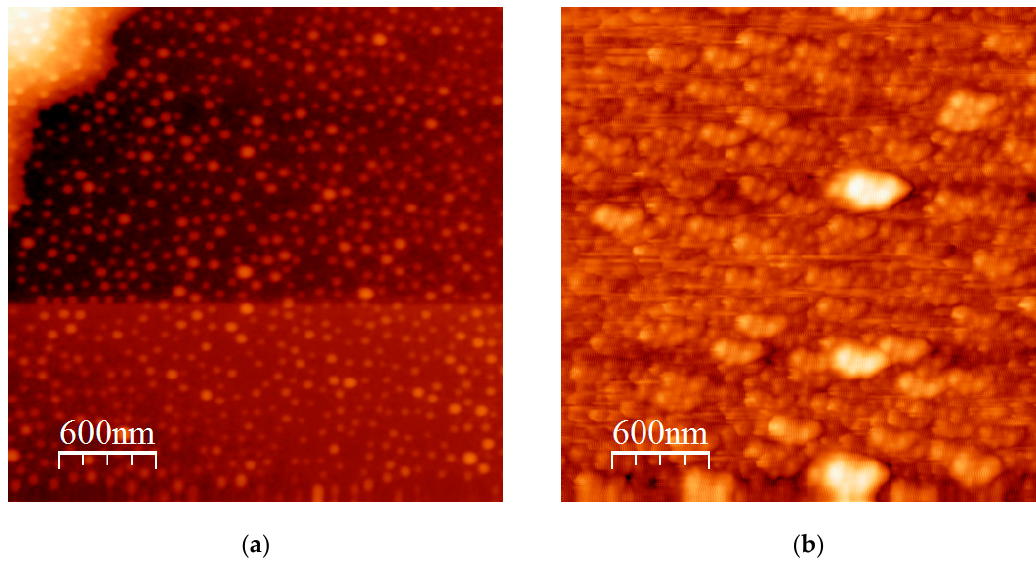
Figure 9. ( a ) AFM height image of HSH102/46/54 and ( b ) AFM height image of HSH187/41/59.